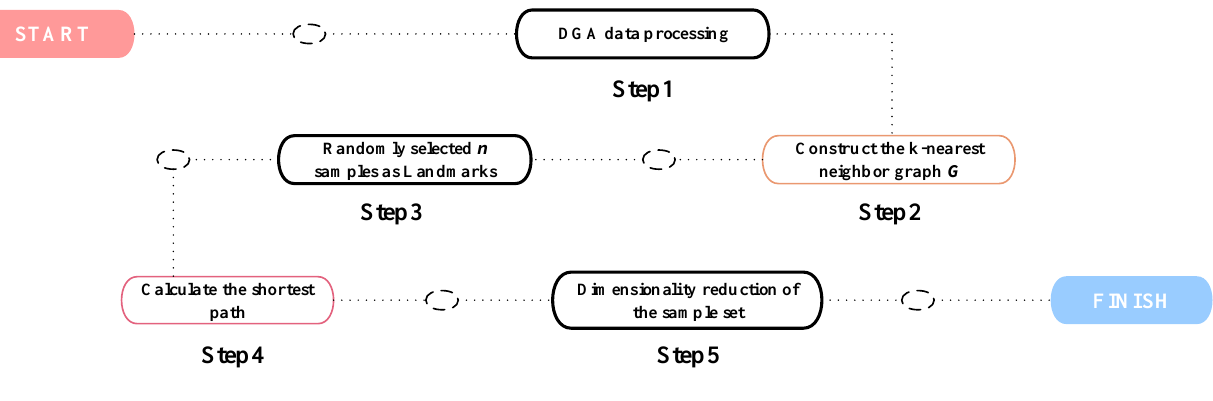
Figure 1. Data processing flow of L-Isomap.